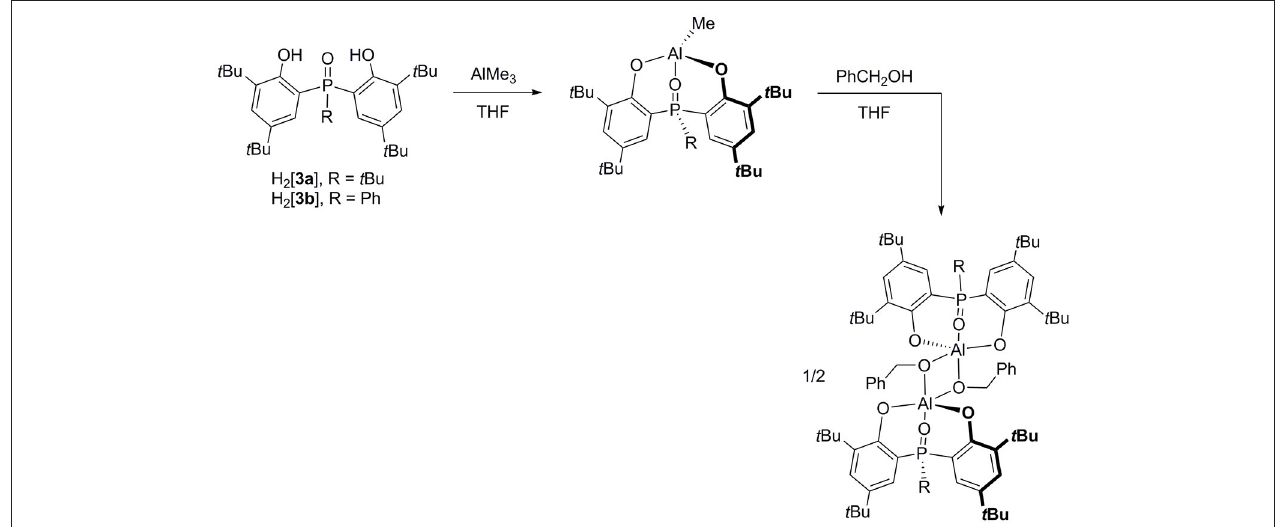
FIGURE 2 | Synthesis of biphenolate phosphinoxide complexes of aluminum.